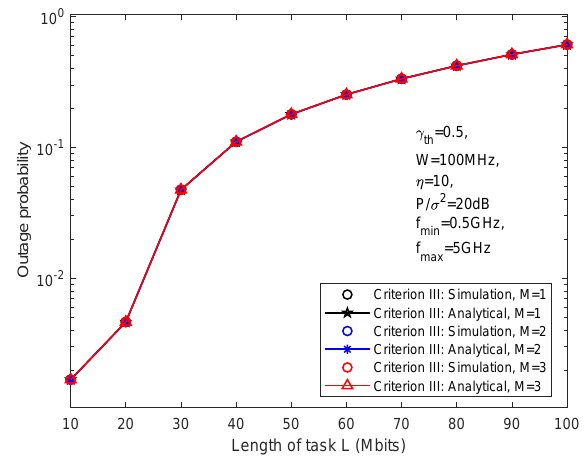
Figure 4. Outage probability versus the task length L for criterion III.